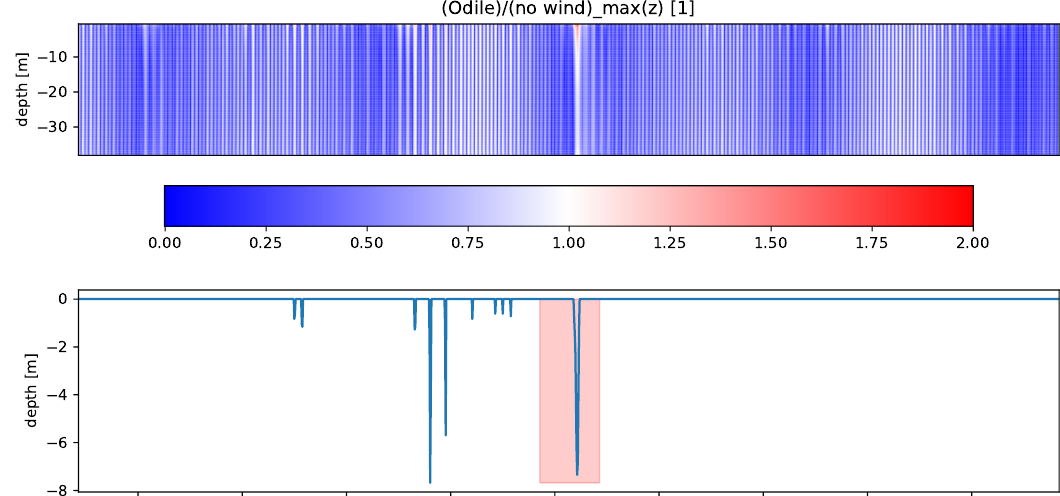
Figure 18. Safe depth at lat = 28.260 N lon = − 111.772 W. Safe depth is here defined as the depth where the velocity never exceeds 1.15 v max ( z ) , the maximum velocity in the no-wind simulation, during the period starting at day five and finishing at the end of the simulation. The red rectangle indicates the period of Odile. The top two panels show the velocity profiles without and with Odile winds. The third panel from the top shows the velocity profile with Odile winds, normalised by the maximum velocity observed for the no wind case at the respective depth, therefore, showing a representation of safe depth before the restriction to a certain assumed safe current. The bottom panel shows the iso-line of the assumed safe current of 115%, as per the definition of the safe depth. All dates in